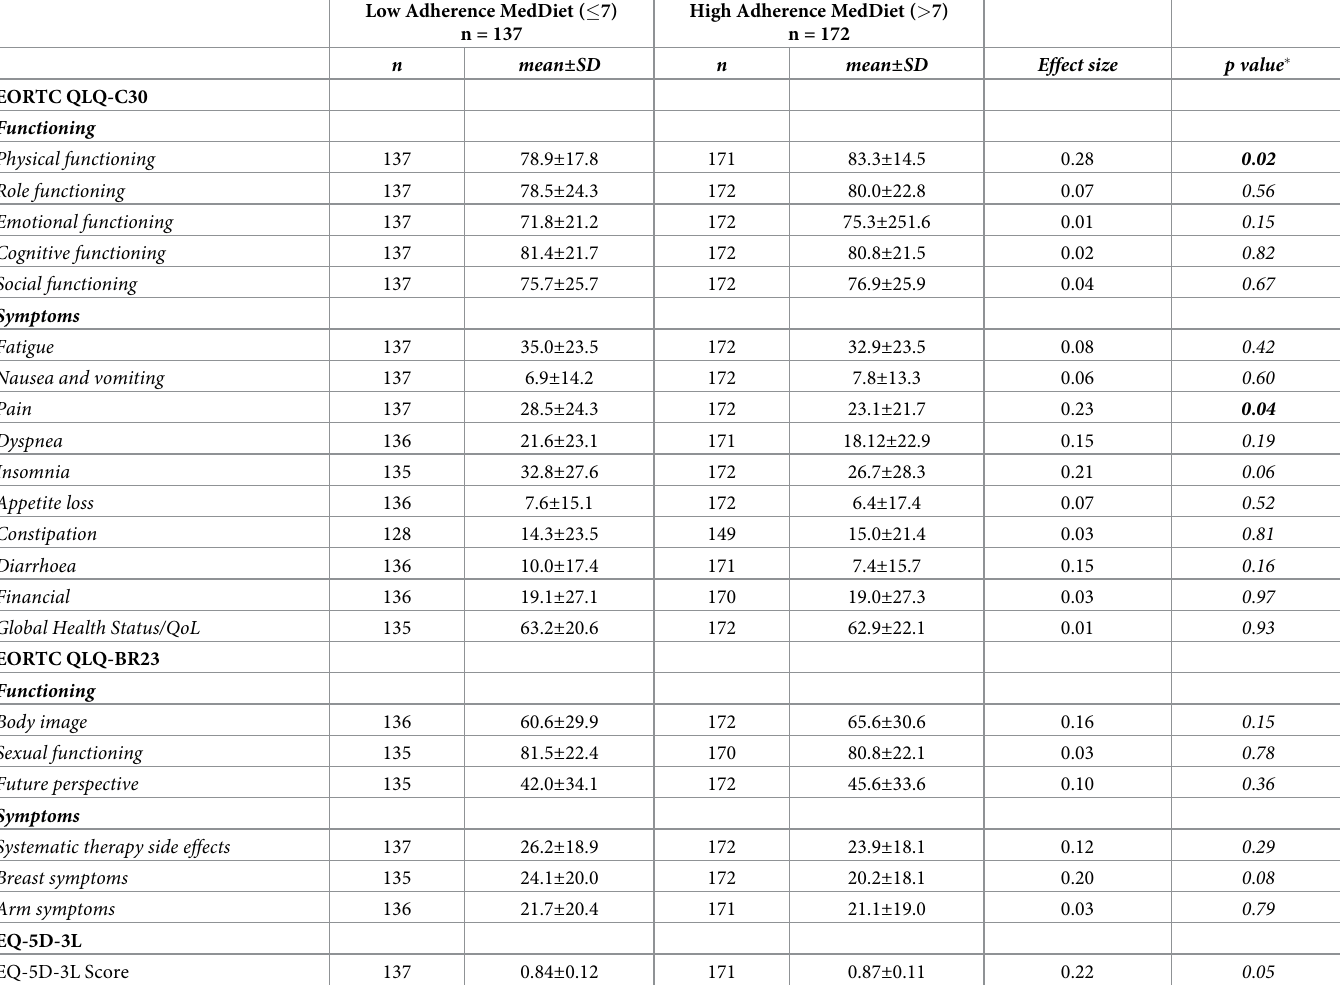
Table 3. Mean scores (SD) of HRQoL questionnaires (EORTC QLQ-C30, EORTC QLQ-BR23, EQ-5D-3L) according to categories of adherence to Mediterranean Diet in breast cancer